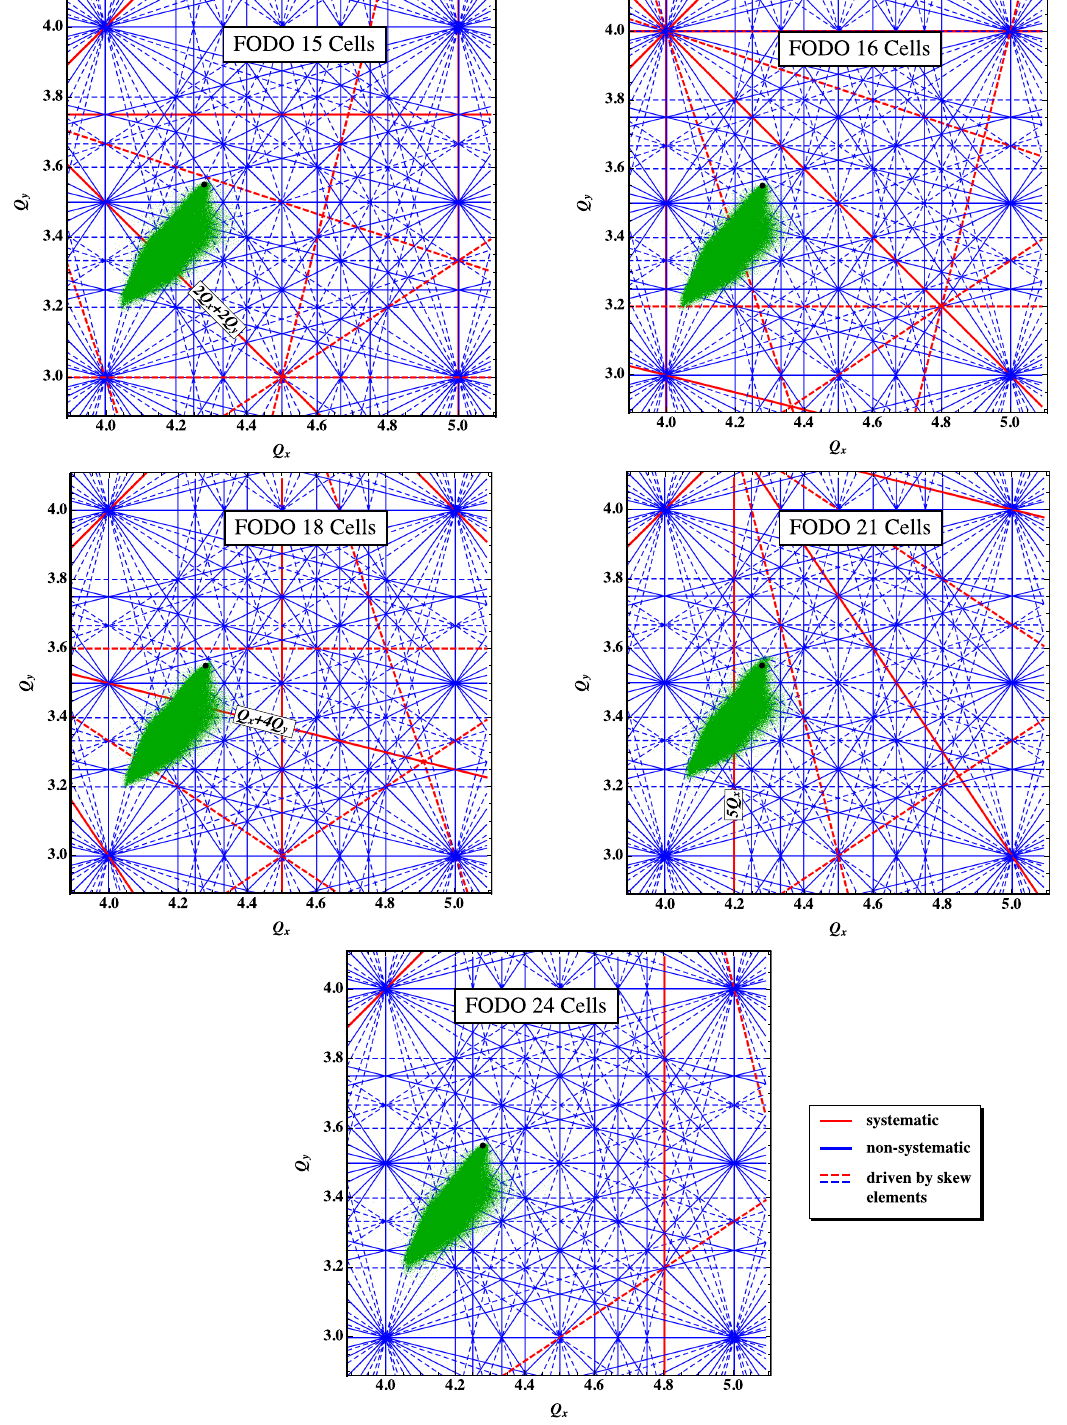
FIG. 26. Resonance diagram up to 5th order and tune footprint after 5000 turns for the regular FODO lattice with periodicity 15, 16, 18, 21, and